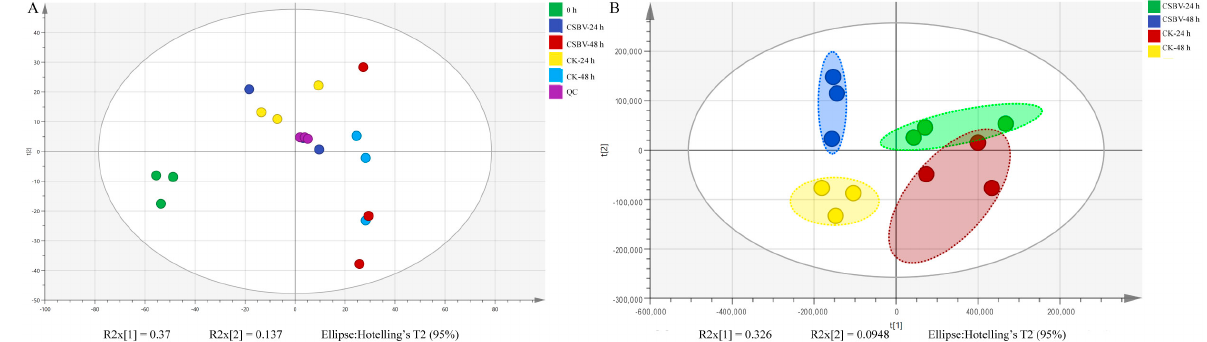
Figure 2. Score plots obtained from PCA ( A ) and PLSDA ( B ) analysis of the present lipidomics data in both CSBV-infected and healthy larvae.